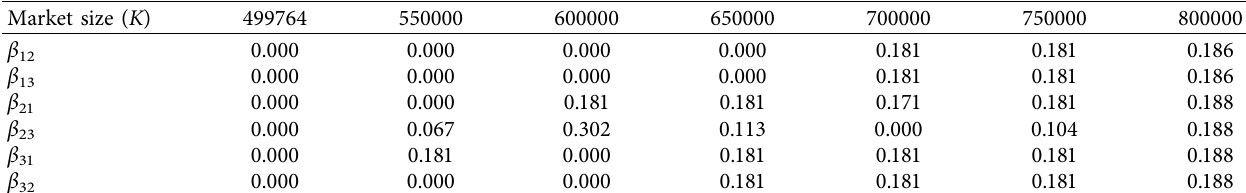
Table 7: Simulation of symbiotic relationship of balanced growth of three